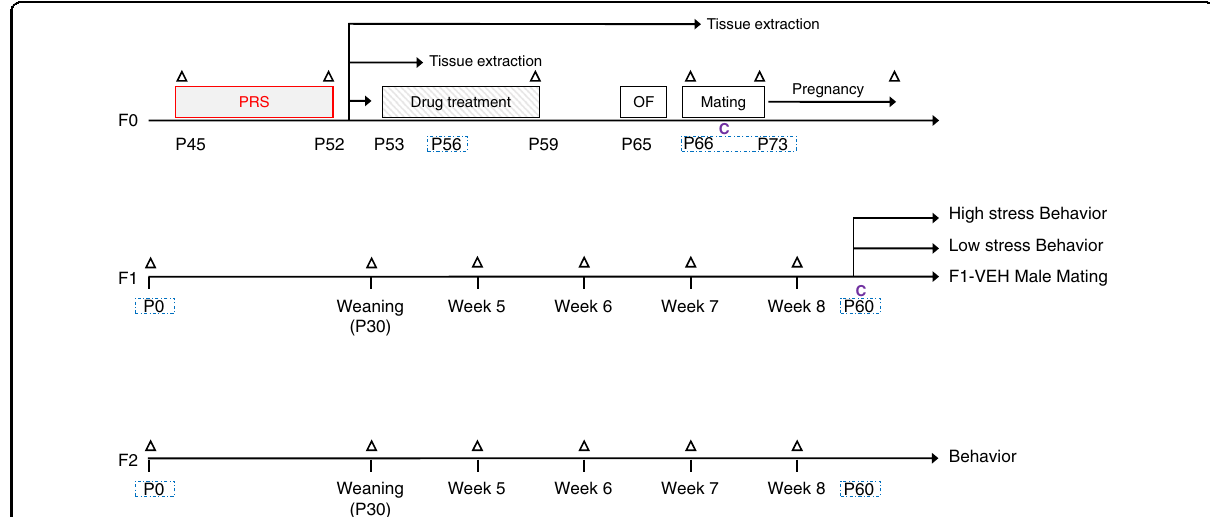
Fig. 1 Experimental procedure. Timeline of the experimental procedure in the parent (F0) and offspring (F1 and F2) generations. Triangle: determination of weight. Blue dashed rectangle: assessment of gene expression and/or miRNA levels. C: assessment of CORT